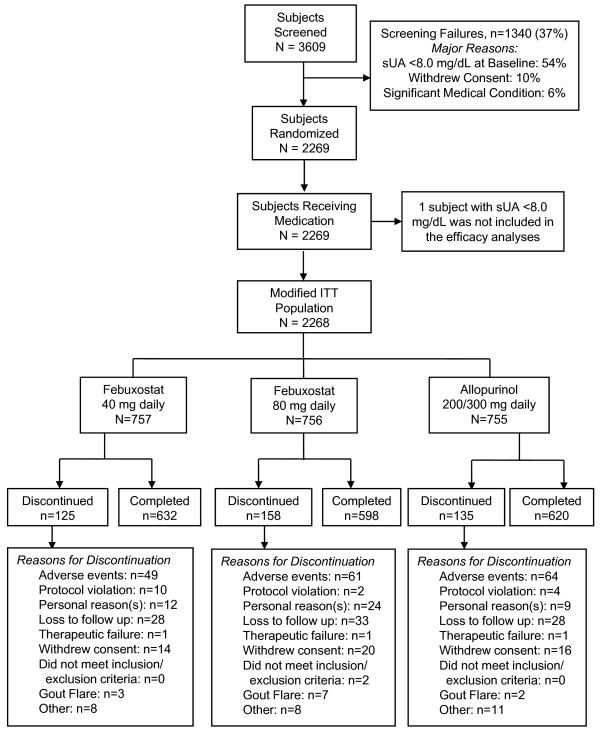
Flow of subjects through the study. One subject randomized to allopurinol was not included in the efficacy analyses because baseline serum urate (sUA) did not meet inclusion criterion. The remaining 2,268 subjects eligible for the study comprised the group in which efficacy was assessed.